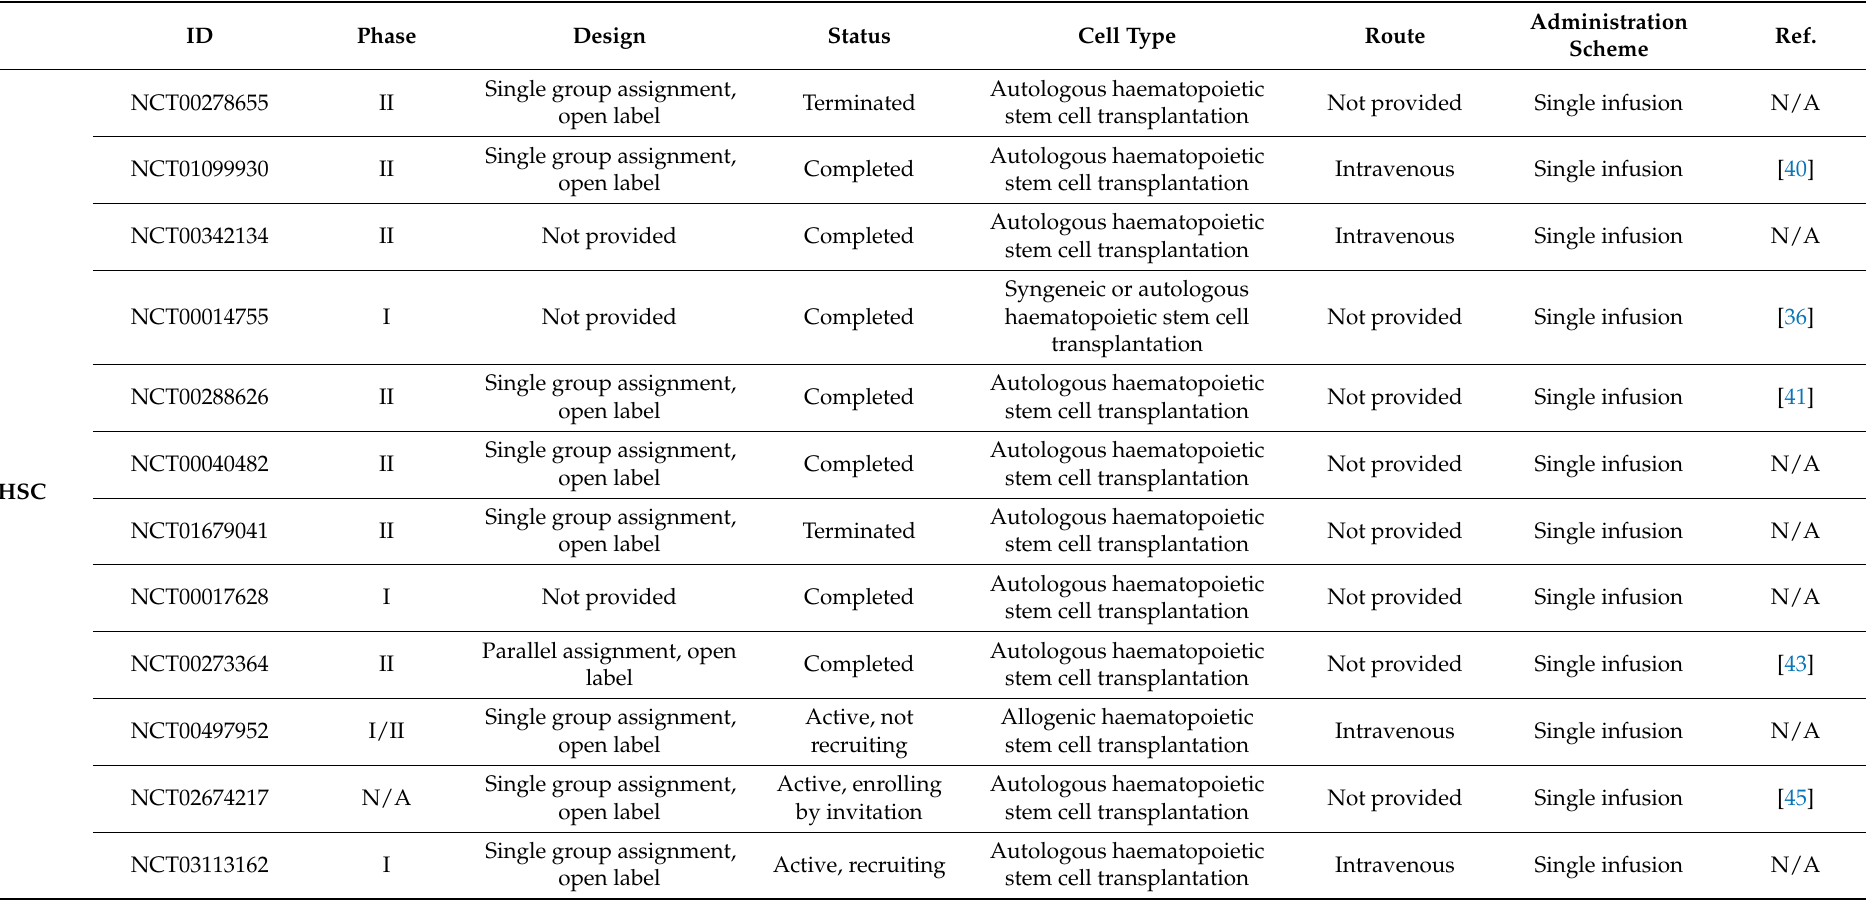
Table 1. Clinical trials in multiple sclerosis (MS) patients. All clinical trials using haematopoietic stem cells (HSC), mesenchymal stem cells (MSC), regulatory T cells (Treg), tolerogenic dendritic cells (tolDC), peptide-coupled peripheral blood mononuclear cells (PBMC) and peptide-coupled erythrocytes (RBC) in MS. A search was conducted in ClinicalTrials.gov on the 16th of June